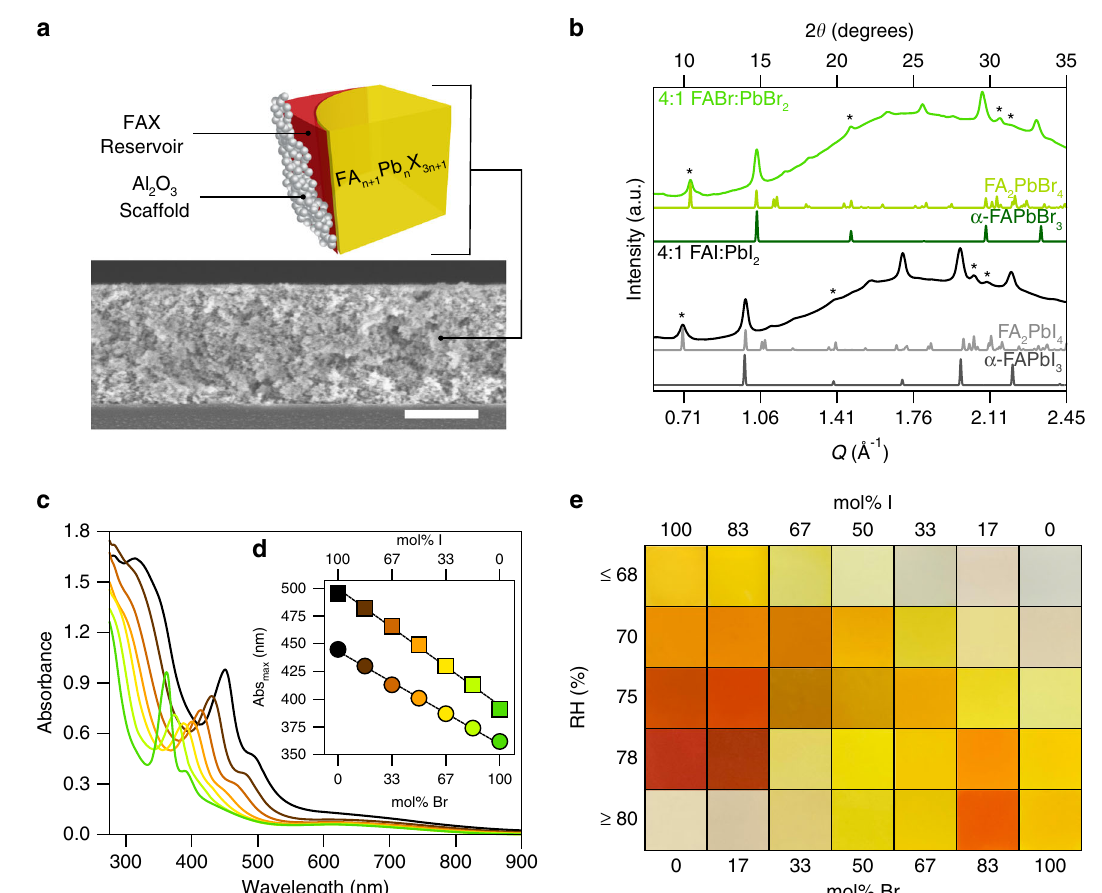
Fig. 1 FA n + 1 Pb n X 3n + 1 composite fi lm characterization and reversible chromism. a Illustration showing the components of a FA n + 1 Pb n X 3n + 1 composite fi lm, including FA µ m. b Wide angle X-ray scattering (WAXS) patterns of composite n + 1 Pb n X 3n + 1 , FAX reservoir, and Al 2 O 3 scaffold. Scale bar is 1 FA n + 1 Pb n X 3n + 1 fi lms. The 2 θ axis in ( b ) is relative to Cu K α (1.5406 Å, 8.04 eV) radiation and was calculated from Q = 4 π sin( θ )/ λ where λ is the excitation wavelength. The background scattering in ( b ) is caused by the Al 2 O 3 scaffold and glass substrate. * = FA 2 PbX 4 . Reference patterns of α -FAPbI 3 were obtained from the Materials Design Group 78 , and the reference pattern of FA 2 PbI 4 was obtained from ref. 37 . Reference pattern of FA 2 PbBr 4 was generated from FA 2 PbI 4 by substituting Br in place of I and multiplying the unit cell volume by the Br/I radius ratio. c Absorbance spectra and d absorbance maxima as a function of composition for FA n + 1 Pb n X 3n + 1 fi lms. Circles in d correspond to the strong excitonic peak tunable between 450 and 360 nm ( n = 1) while squares correspond to the absorption edge tunable between 500 and 390 nm ( n > 1), respectively. e Representative optical photographs of composite FA n + 1 Pb n X 3n + 1 fi lms highlighting the diverse colors obtainable upon exposure to humidity. [PbI 2 ] = 0.75 M in dimethyl sulfoxide (DMSO) was held constant in all precursors, which were spun onto a 1.58 ± 0.02 µ m Al 2 O 3 scaffold and annealed at 60 °C for 10 min. Note that fi lms rich in iodide (>80% I) or bromide (>67% Br) bleach to white/transparent upon exposure to >80% or <68% relative humidity (RH), (Fig. 1e). The equilibrium is described by Eq. 1 (see Supple- The optically active crystalline FA n + 1 Pb n X 3n + 1 (X = I, Br) mentary Note 1 for a derivation of q ): domains are composed of predominantly n = 1 and n = 2 layers. FA n + 1 Pb n X 3n + 1 domains exhibit compositionally tunable optical properties that vary linearly as the halide ratio is varied from 100% iodide to 100% bromide (Fig. 1c, d) with two absorption peaks: (1) a strong excitonic peak tunable between 450 and 360 nm (circles) and (2) an absorption edge tunable between 500 and 390 nm (squares) that correspond to n = 1 and n = 2 layers, The dynamic equilibrium is shifted by modulating the strength respectively. The optical properties observed for composite and number of H-bonds between solvent molecules, reservoir, FA n + 1 Pb n X 3n + 1 fi lms are consistent with other 2D MHPs 41,43 – 46 . and MHP. This insight allows us to design composite materials Reversible chromism in layered FA-based MHPs . Composite FA n + 1 Pb n X 3n + 1 fi lms show a brilliant array of reversible colora- (thermochromism) by reversibly forming compounds that span tion upon exposure to solvent vapor. The visual appearance of composite FA n + 1 Pb n X 3n + 1 fi lms range from colorless to yellow, orange, red, and brown (Fig. 1e). We attribute the mechanism of color change to a dynamic equilibrium between FAX salt pairs intercalated into the FA n + 1 Pb n X 3n + 1 domain or shuttled to an adjacent amorphous “ reservoir ” domain composed of excess FAX vapor must interact favorably with FA n + 1 Pb n X 3n + 1 . In order to